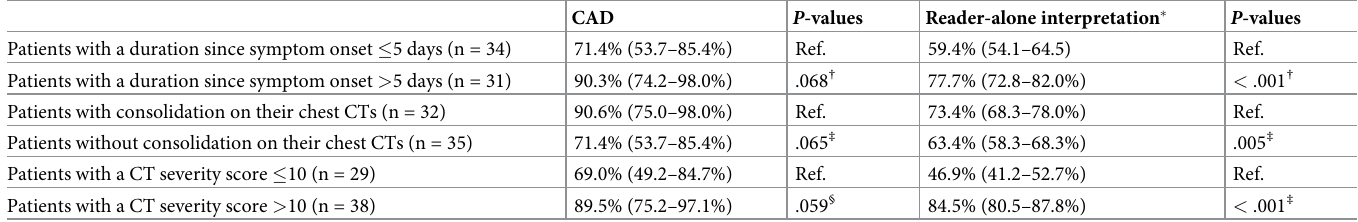
Table 4. Sensitivities varied by clinical and radiological findings.